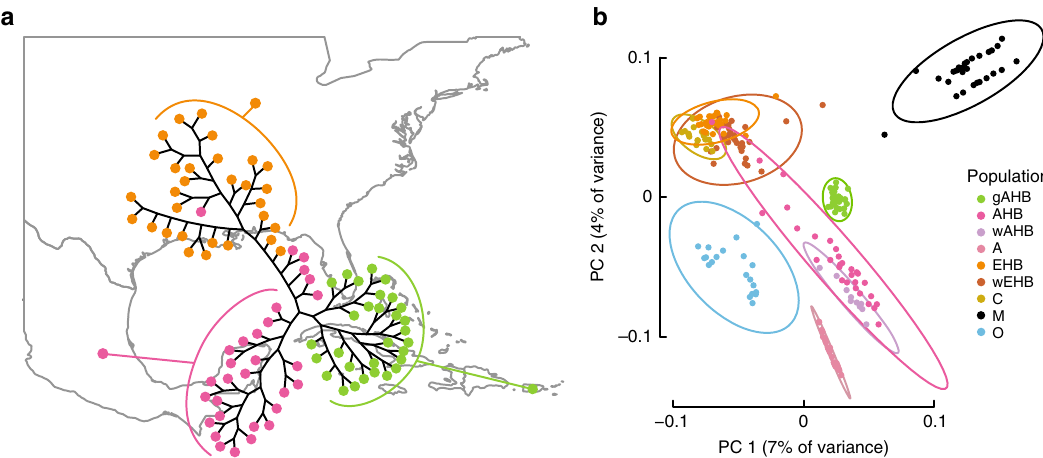
Fig. 3 Population structure and patterns of admixture across EHB, AHB, and gAHB. a A diagrammatic superimposition of an un-rooted Neighbor Joining (NJ) cladogram of the samples with population geography. The NJ tree was constructed from 2,808,570 SNPs derived from whole-genome sequencing. Taxa represent the 90 samples assessed in this study, with fi ll color corresponding to population membership. b Principal component analysis (PCA) showing population structure of 230 samples with 1,049,512 SNPs common between the 90 samples in a and 140 previously-described samples of wild and domesticated honeybees from Europe, Africa, and North and South America 29 . Ellipses in the PCA enclose the 95th percentile of actual population membership with ellipse color corresponding to population as above. The gAHB, AHB, and EHB group labels are the populations sampled in this study. Remaining labels are aggregates of samples from the previous study 29 grouped as follows: wAHB is a Brazilian AHB population; wEHB are domestic EHB population samples from both Minnesota, USA, and Sweden; groups A, O, M, and C are genetic groupings spanning multiple, distinct subspecies of A. mellifera as identi fi ed in prior reference studies 15,